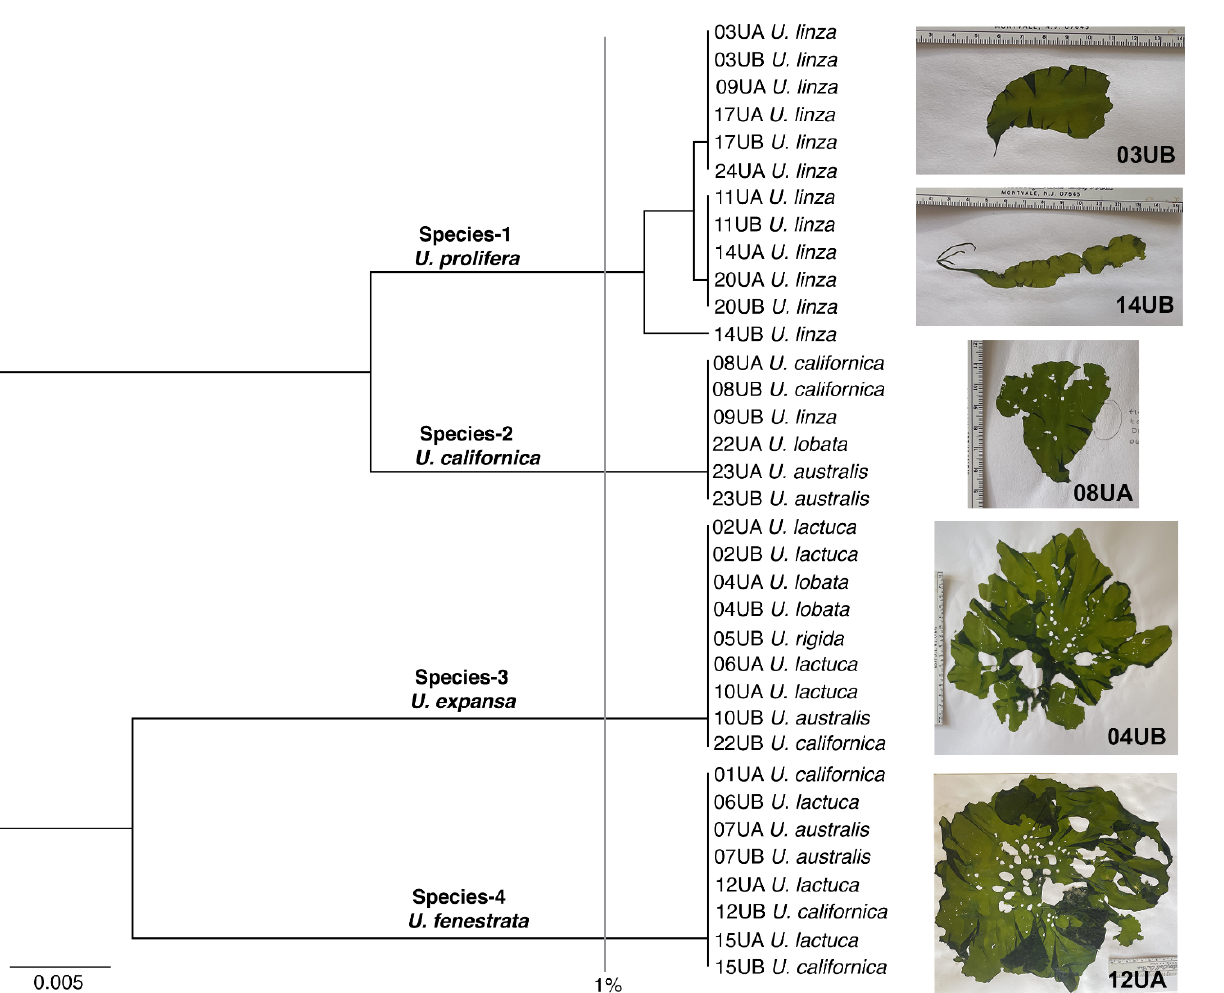
Figure 1. UPGMA tufA cluster analysis for 35 blade-form Ulva specimens collected at different intertidal zones from three sites in the San Juan Islands. Specimen labels include the collection number (e.g., ‘03UA’) followed by the morphological identification of the specimen based on the Gabrielson and Lindstrom [1] key. The 1% sequence divergence level is indicated by the grey vertical line and example images of specimens are shown on the right. Table 2. Intra- and interspecific divergences among tufA sequences from 35 specimens of four blade- form Ulva species collected in the San Juan Islands, WA. Gray background = intraspecific diver- gences; white background = interspecific divergences.